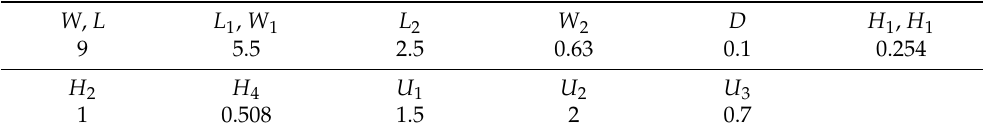
Figure 3. Views of the proposed antenna. ( a ) Perspective view. ( b ) Top view. ( c ) Side view. Table 1. Dimensions for the proposed